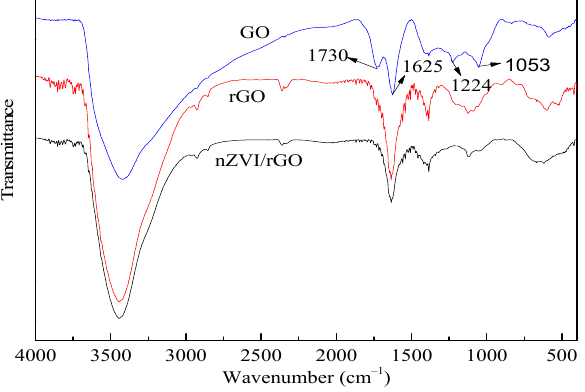
Figure 1. FTIR spectra of GO, rGO, and nZVI/rGO.